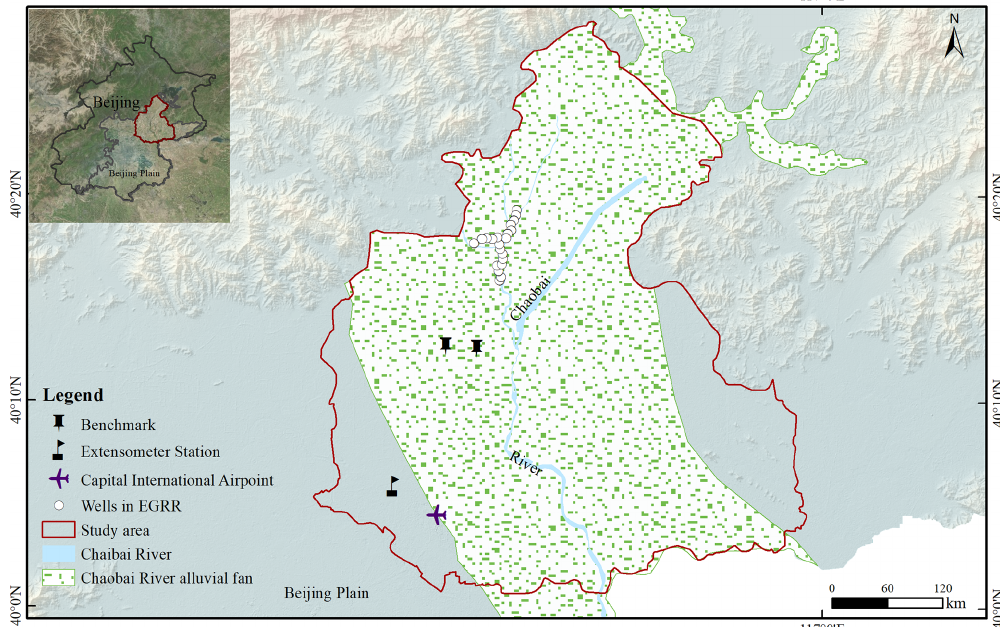
Figure 4. Location of the study area with the digital elevation model from the Shuttle Radar Topography Mission (SRTM). The EGRR location and the land subsidence monitoring station used to calibrate the PS-InSAR outcome are